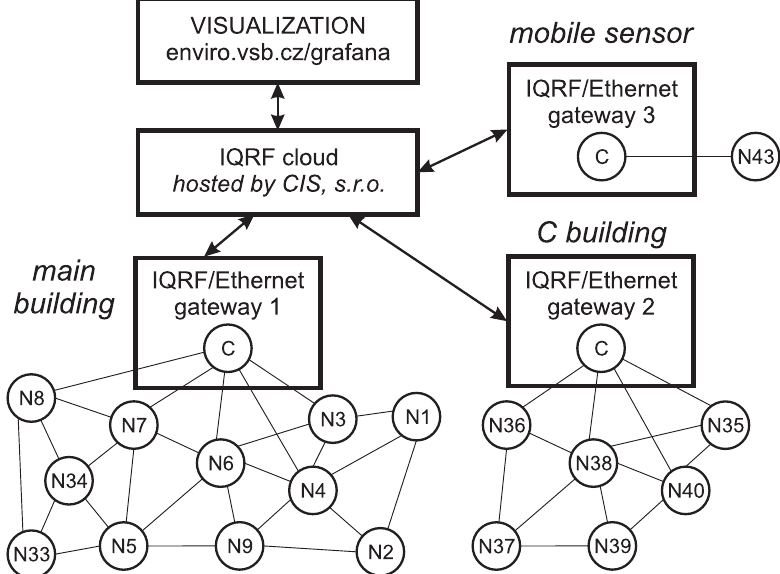
Figure 13. Block scheme for monitoring the environmental quantities at the Grammar School and Secondary School of Electrical Engineering and Computer Science, Frenštát pod